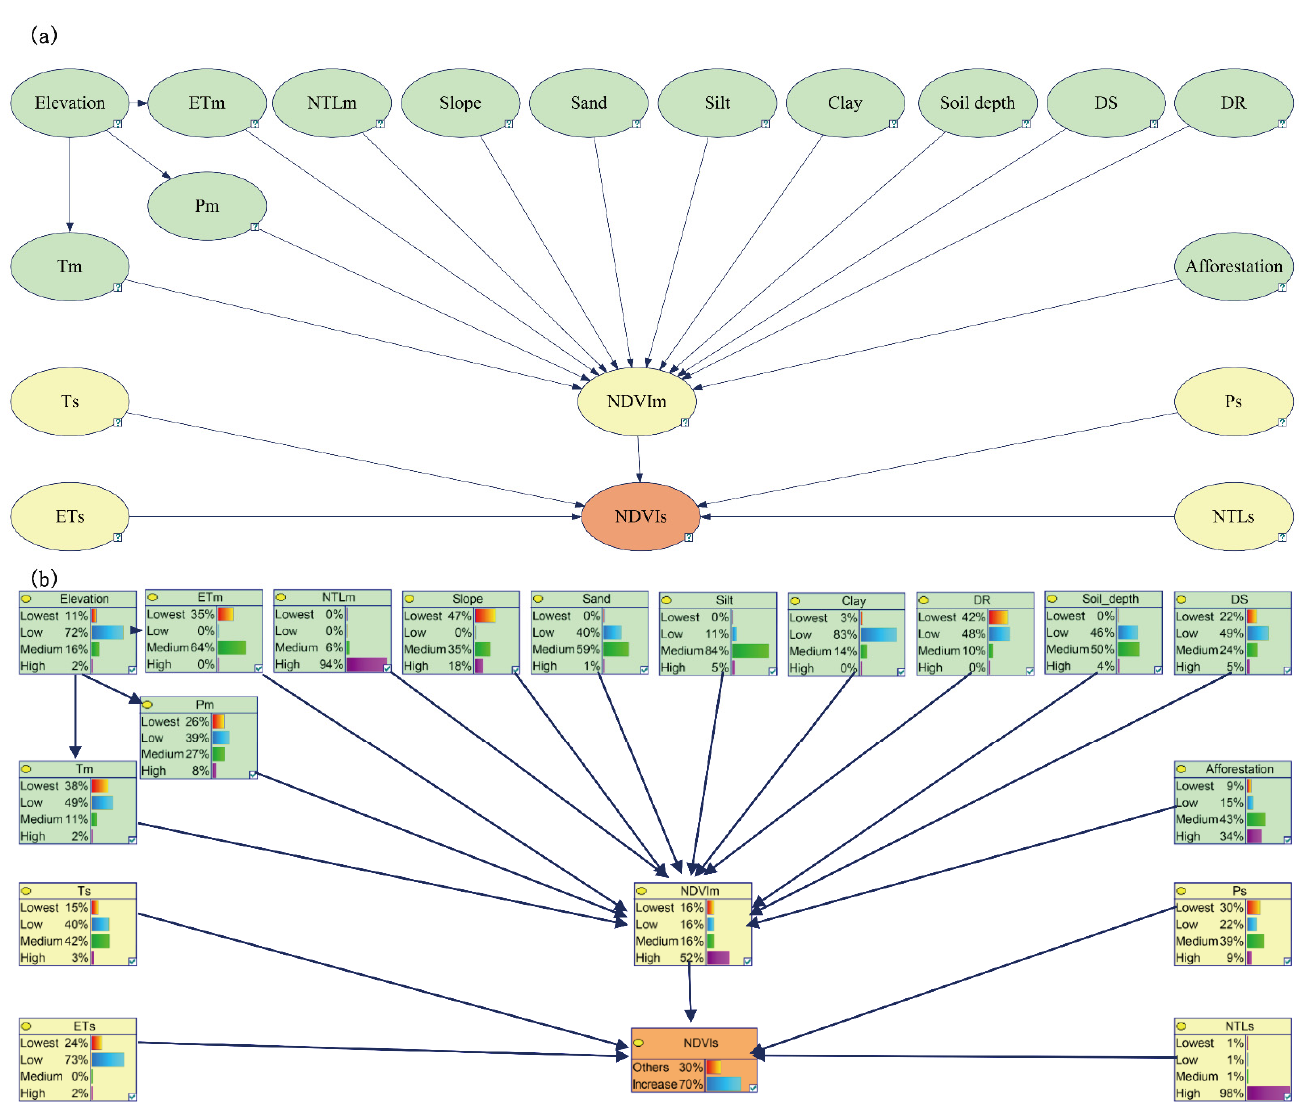
Figure 6. Bayesian conceptual network and parametric results of forest restoration model. (a) Bayesian conceptual network of forest restoration model; and (b) Parametric results of forest restoration model.